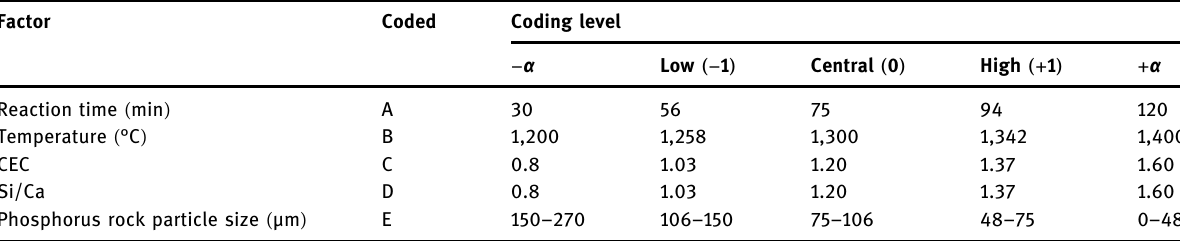
Table 3: Factors and coding levels of response surface analysis